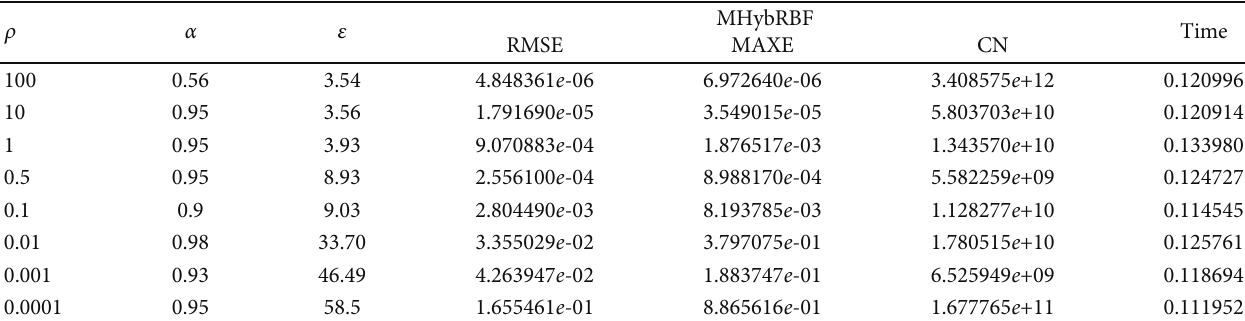
Table 4: The results of MHybRBF with optimal α , ε and di ff erent ρ